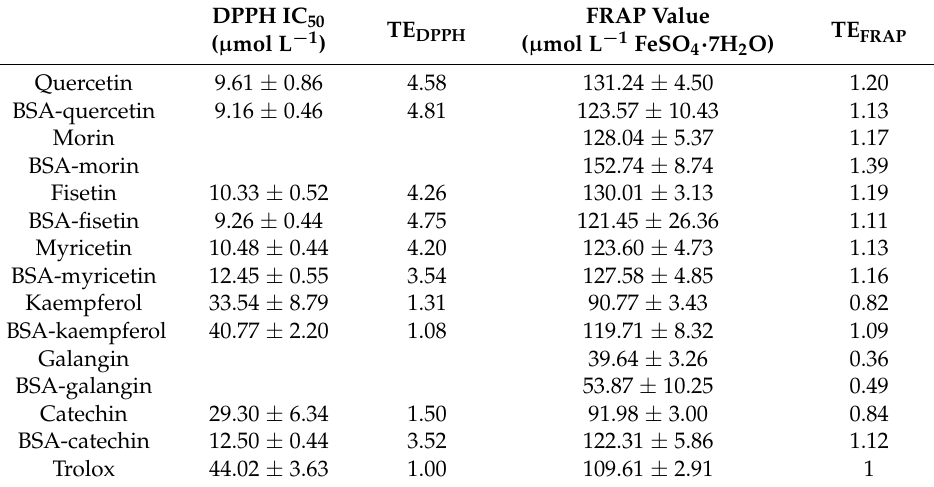
Table 2. IC 50 values of 2,2-diphenyl-1-picrylhydrazyl (DPPH), ferric reducing antioxidant power (FRAP) values and corresponding TE values for different flavonoids and BSA-flavonoids with the DPPH assay and FRAP